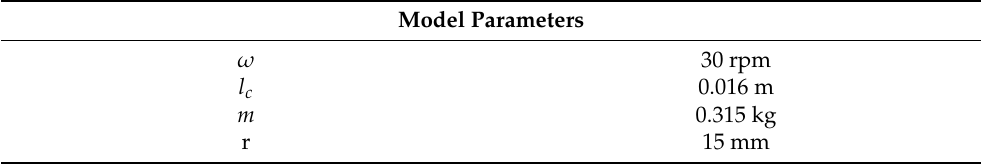
Table 2. Model parameter energy model